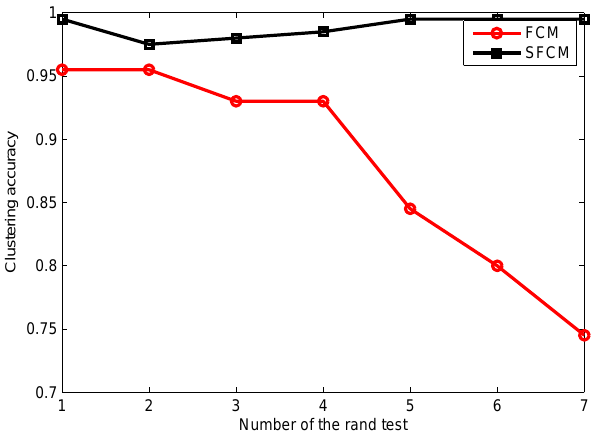
Figure 4. The accuracy of